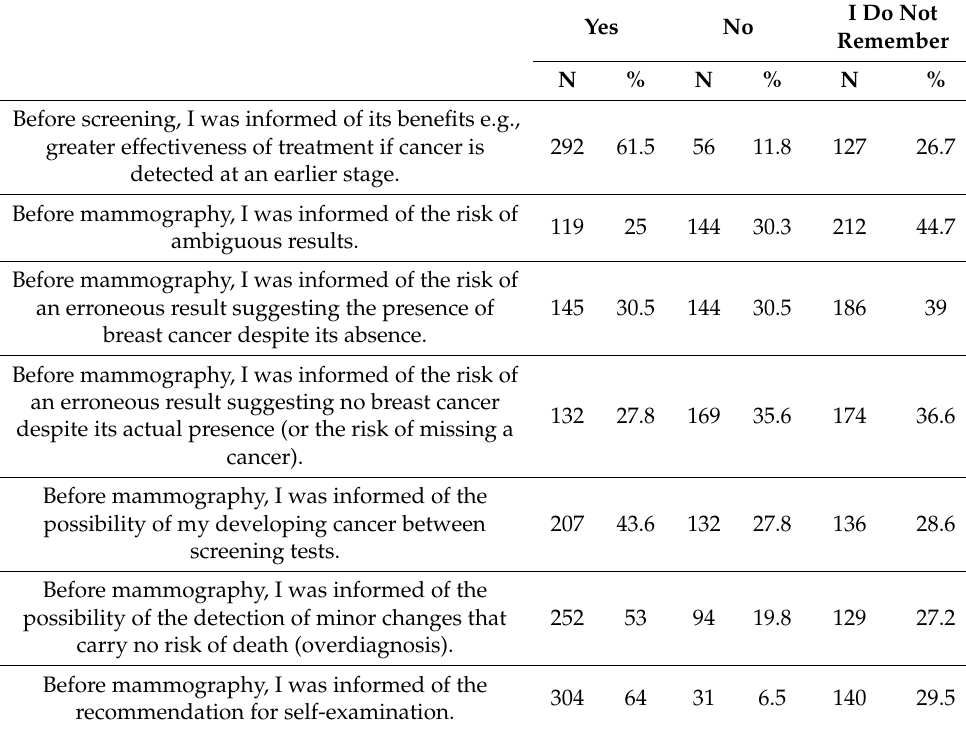
Table 2. Content criteria of